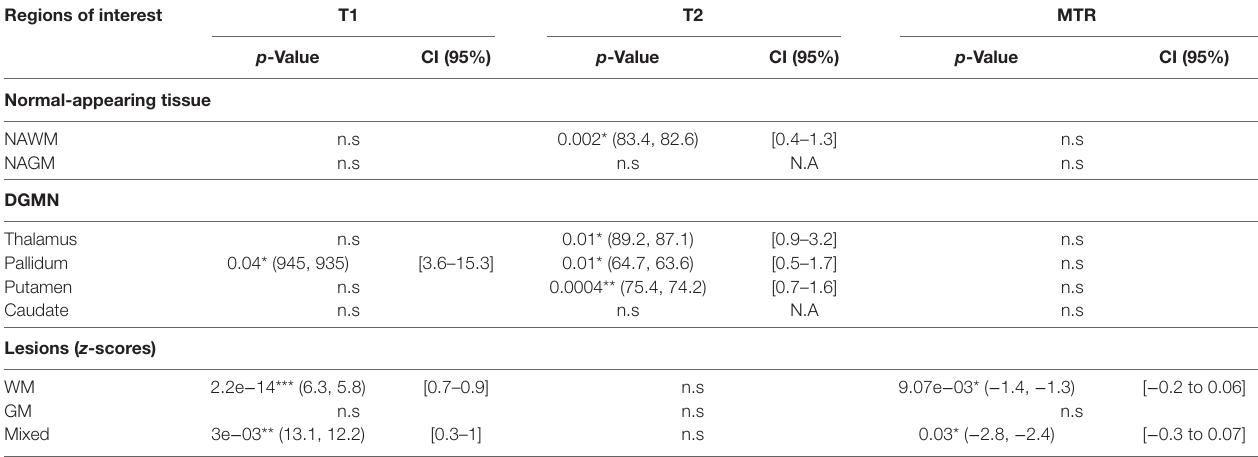
TaBle 4 | Longitudinal analysis results of patients.